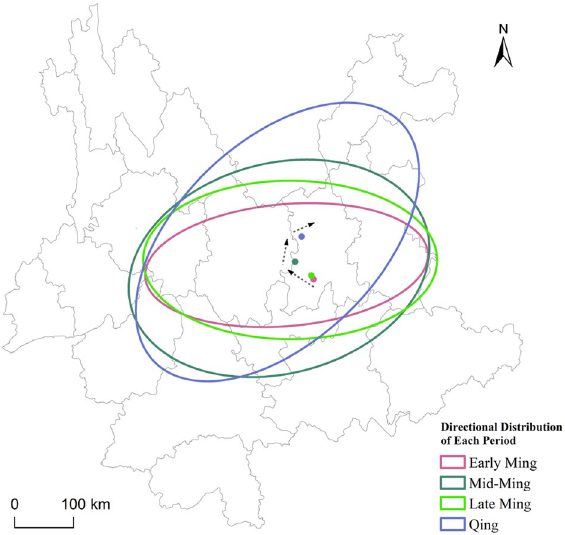
Figure 5. Directional distribution of Biantun toponyms (BTT) in the four periods, arrows indicate the direction change of the distribution of toponyms. The map was created in ArcGIS Pro v.2.7: https:// www. esri. com (Esri, California, USA). The final layout was created in ArcGIS Pro v.2.7: https:// www. esri. com (Esri, California,